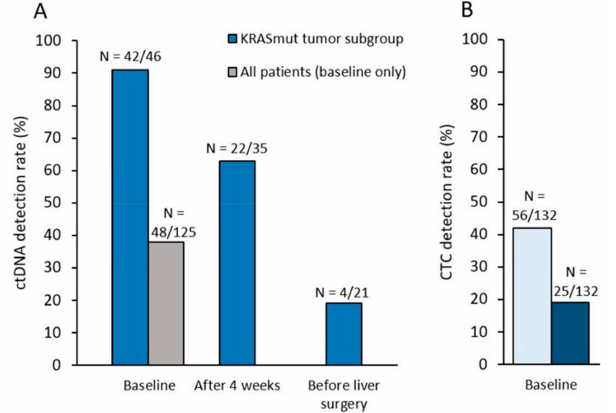
Figure 2. ( A ) ctDNA detection rate (KRAS exon 2 mutation with a variant allele frequency ≥ 0.1%) in all patients at baseline, and in the subgroup of patients with a KRAS exon 2 mutation as determined by routine local assessment on tumor tissues, at baseline, after 4 weeks and before liver surgery (if any). ( B ) CTC detection rate at each timepoint, with the ≥ 1CTC or the ≥ 3CTC / 7.5mL of